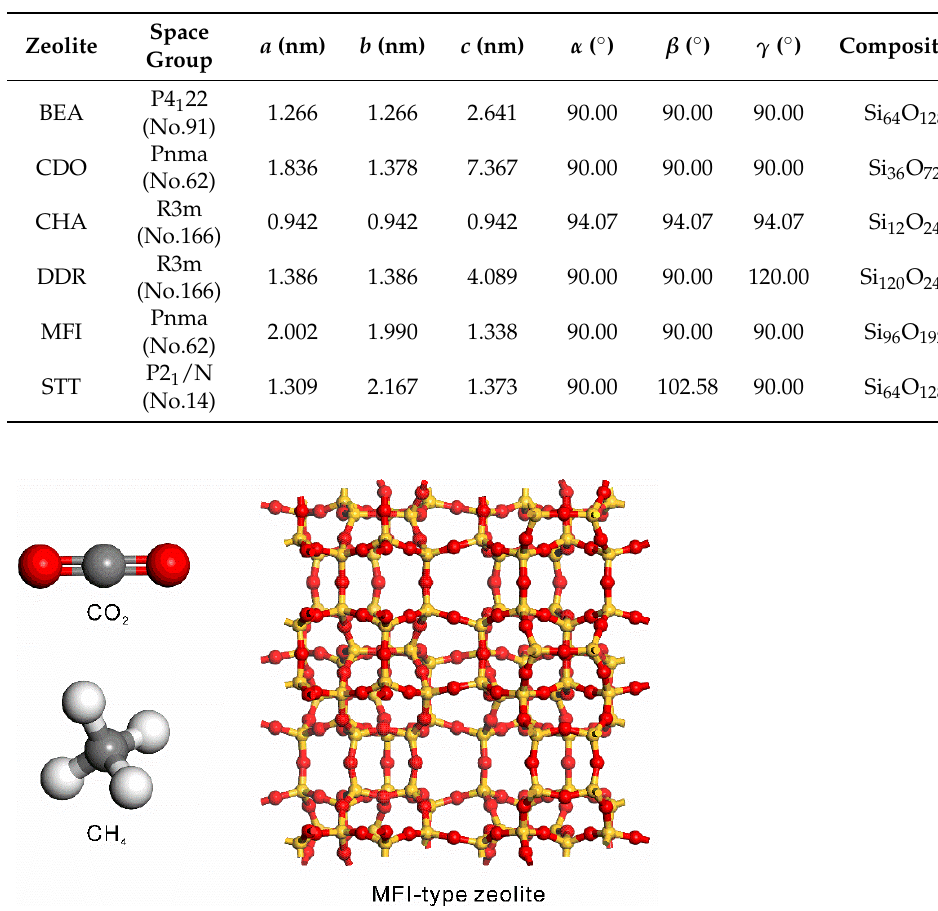
Table 1. Crystal structures of all-silica zeolites.